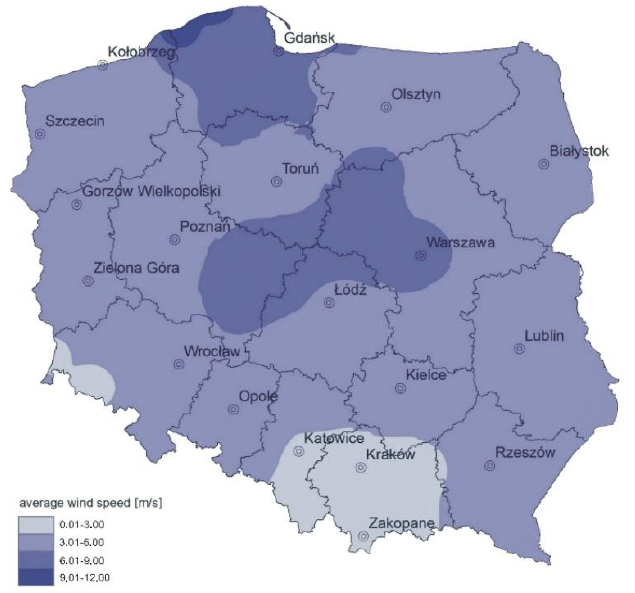
Figure 5. Wind speed analysis. Height of 140 m (own study from [92]).